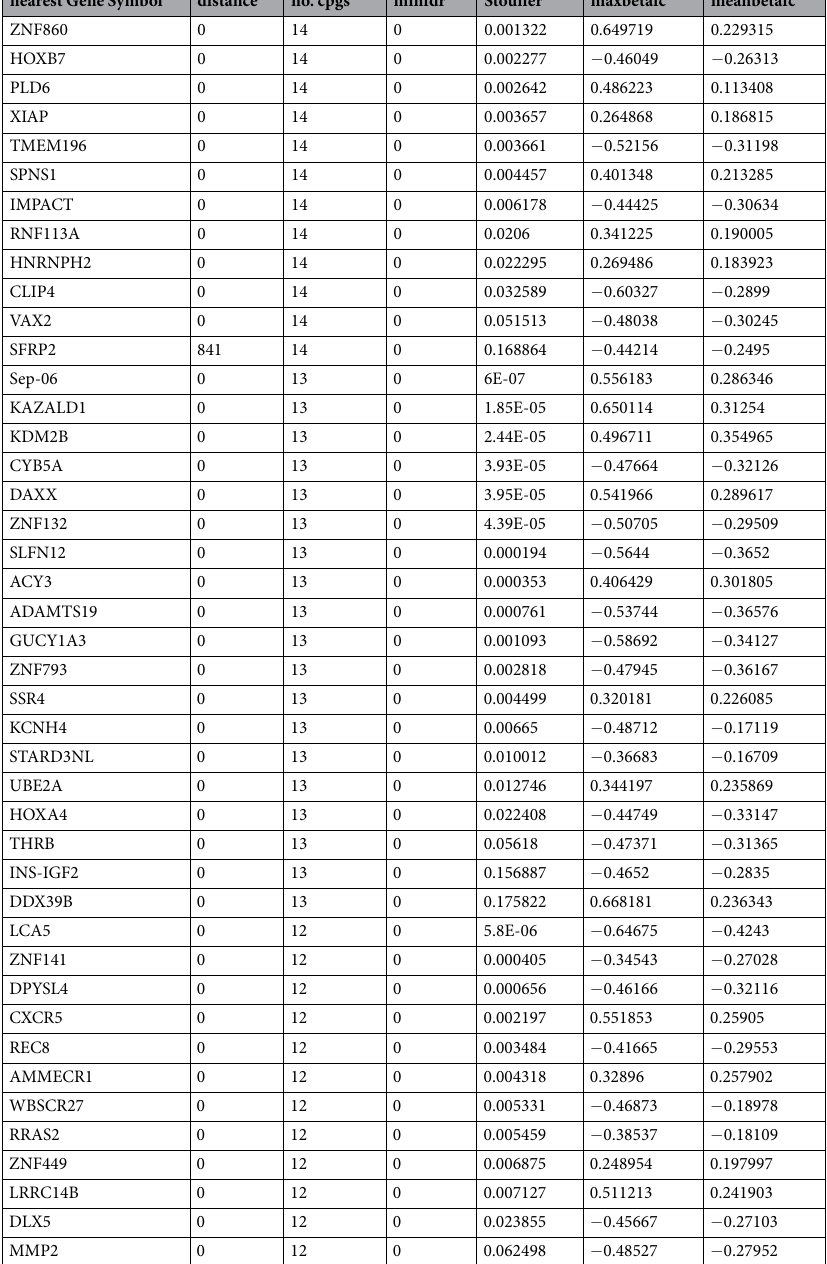
Table 2. Differentially methylated regions (DMRs). Top 100 most significant DMRs are shown (FDR < 0.05, no.probes > 1), sorted by the number of CpGs per